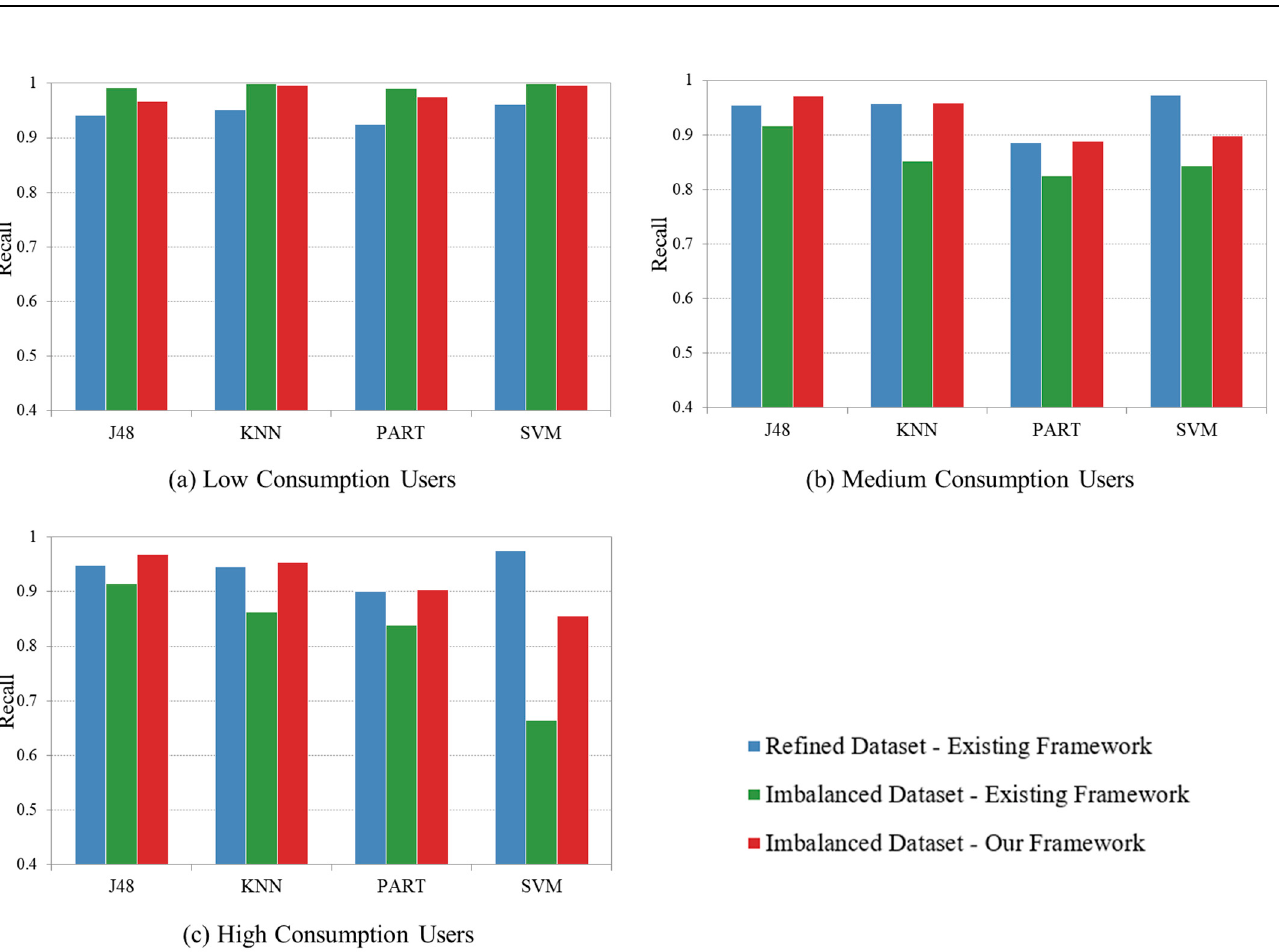
Figure 2. Comparison of recall between different user groups: ( a ) low consumption users; ( b ) medium consumption users; ( c ) high consumption users.